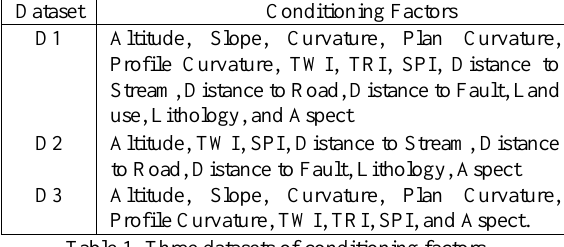
Table 1. Three datasets of conditioning factors.